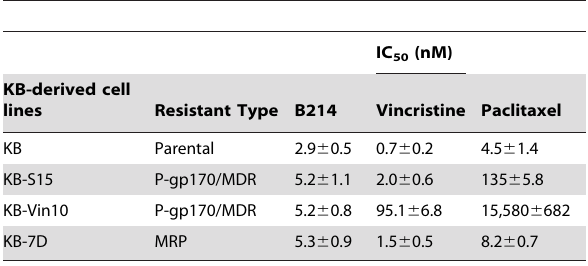
Table 2. Antitumor efficacy of MPT0B214 against KB-derived cell lines with different resistance